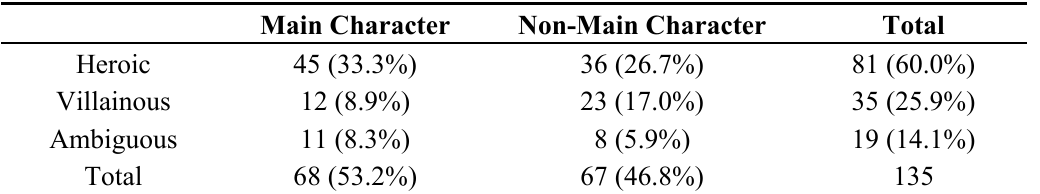
Table 2. Number of nuxia characters in each